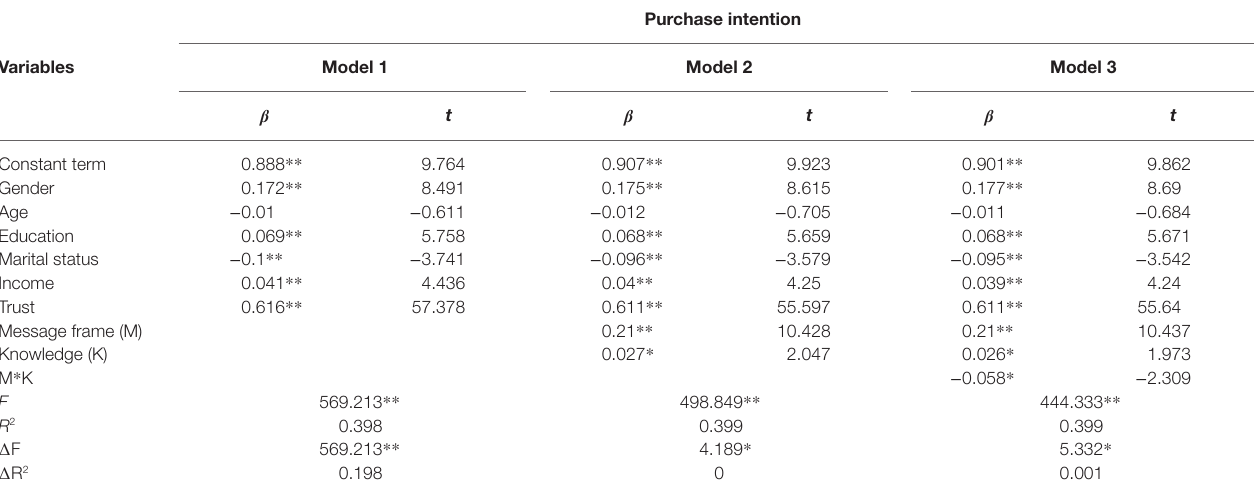
TABLE 4 | Moderating effect of knowledge level on frame effect.